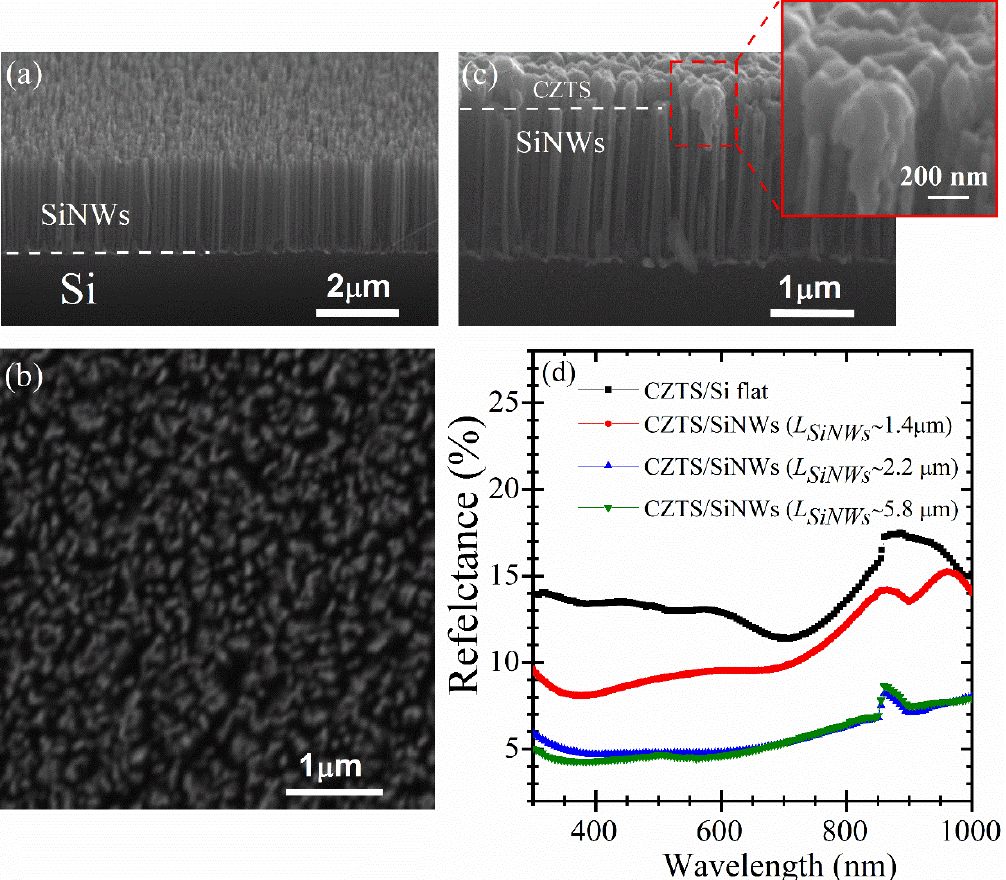
Figure 2. ( a , b ) Top and cross-section SEM images of vertically aligned SiNWs formed after 180 s of MACE on n-Si(100) wafer; ( c ) Cross-sectional SEM view of the CZTS / SiNWs heterostructure (the inset image shows a zoomed area of the CZTS / SiNWs interface); ( d ) The reflectance spectra of CZTS films deposited either on flat-Si or on SiNWs with different lengths ( L SiNWs = 1.4, 2.2 and 5.8 µm).